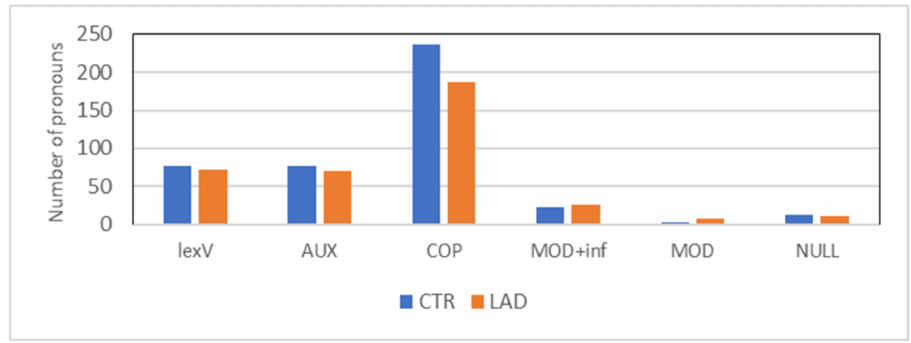
Figure 9. Types of finite verbs in clauses with the propositional pronoun das